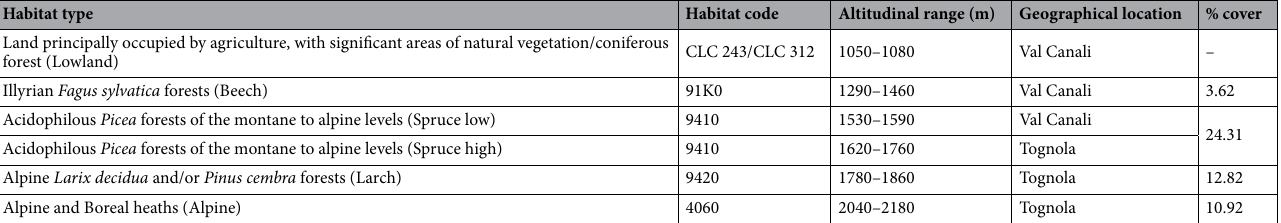
Table 1. The habitat types (according to the EU coding system) selected for the study are described. A contracted description of the habitats is reported in